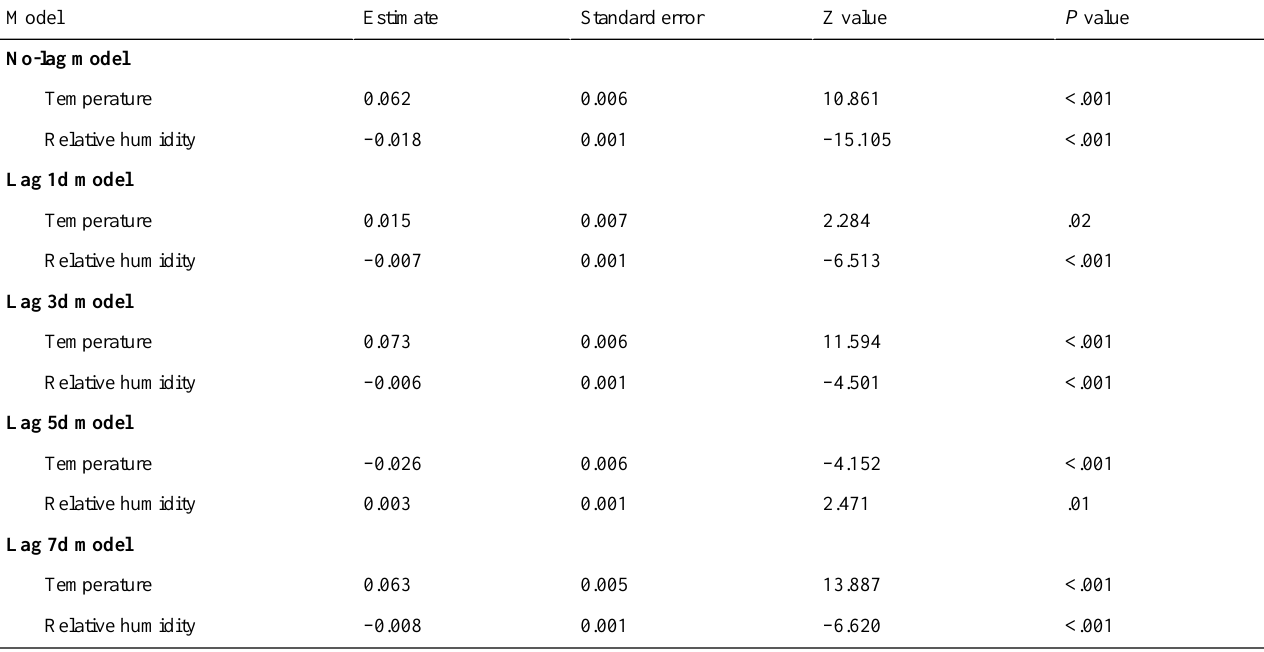
Table 5. Generalized linear modeling of the effects of temperature and relative humidity on daily new cases of COVID-19.